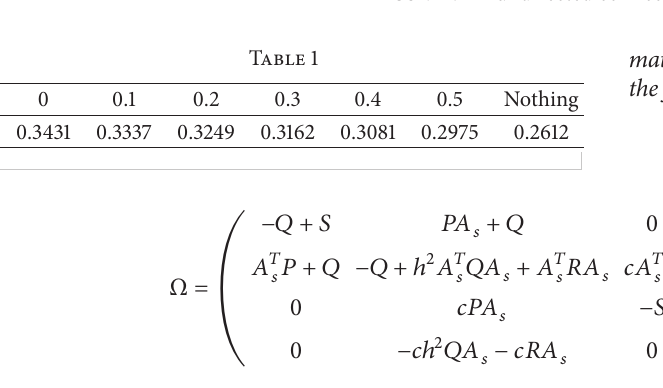
Figure 1: An undirected connected weighted